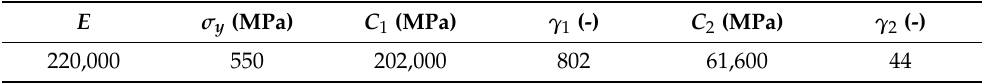
Figure 15. Prediction by the Chaboche model: force vs. total deflection including approximation by Equation (4) ( a ) and total deflection vs. plastic deflection ( b ).